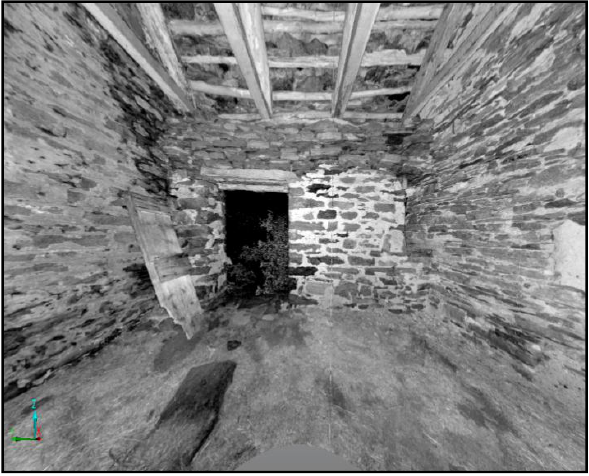
Figure 1. Laser scanner survey of a Veglio (Piedmont,